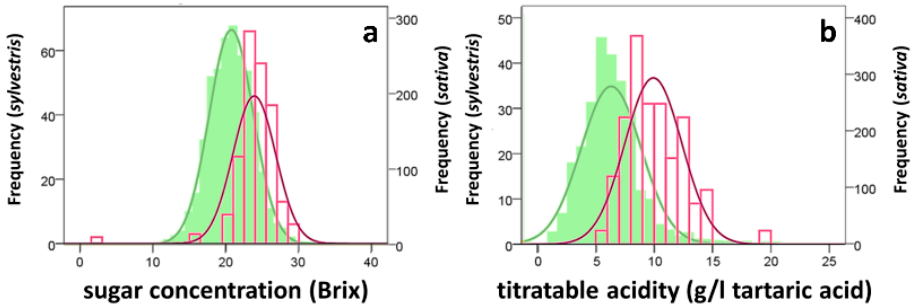
Figure 2. Technological parameters of the must of Vitis vinifera subsp. sylvestris (in pink) and subsp. sativa (in green). Vitis vinifera subsp. sativa data are already published in Rustioni et al. [26]. ( a ): sugar concentration (Brix), ( b ): titratable acidity (g/L tartaric acid).